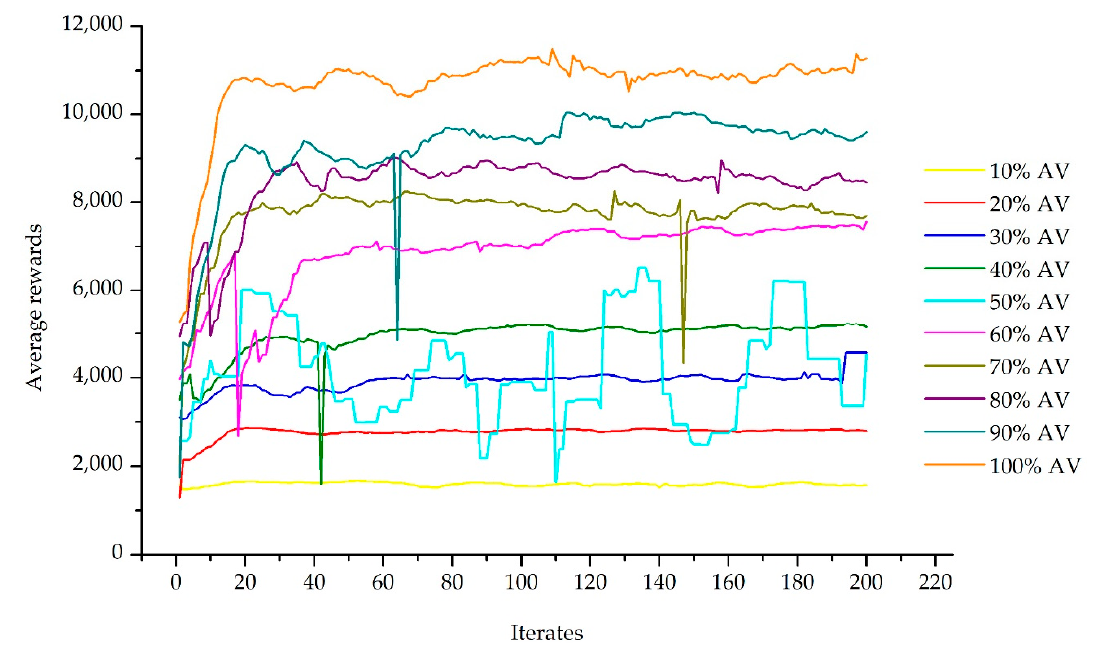
Figure 7. The average reward curve over the 200 iterations based on the AV penetration rate.